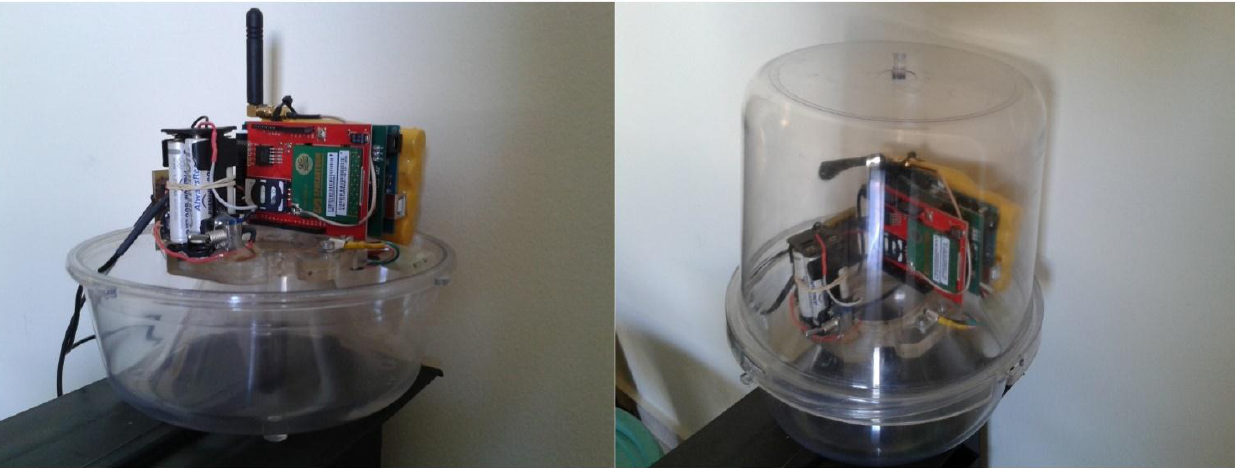
Figure 14. The electronic McPhail trap. ( Left ) Optoelectronic sensor and microcontroller on plexiglass disk; ( Right ) Integrated electronics and trap